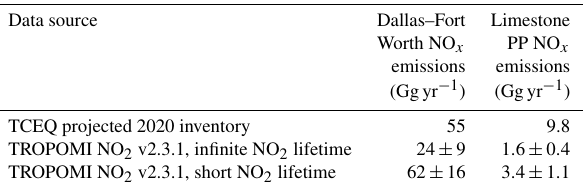
Table 3. NO x emission rates for Dallas–Fort Worth and the Lime- stone power plant from the TCEQ Emissions Inventory and vari- ous iterations of the flux divergence method using the TROPOMI NO 2 v2.3.1